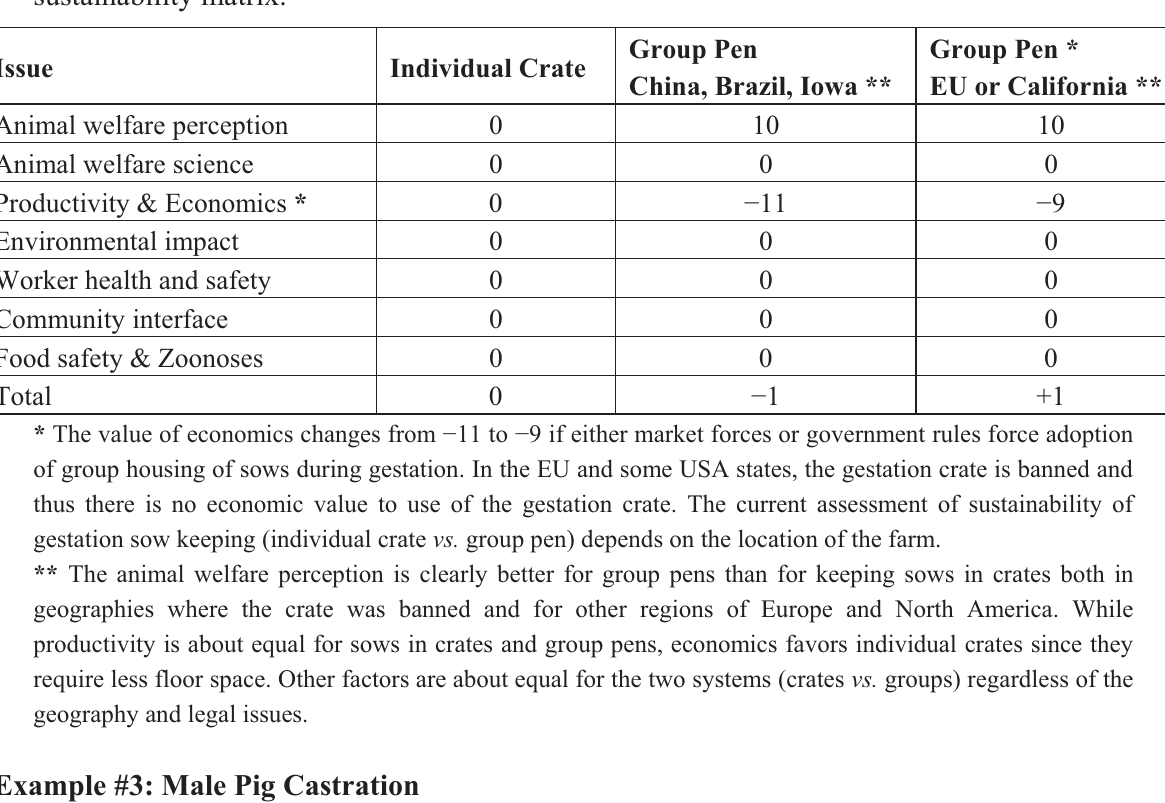
Table 3. Comparison of indoor sow gestation systems: well-managed pen vs. crate using a sustainability